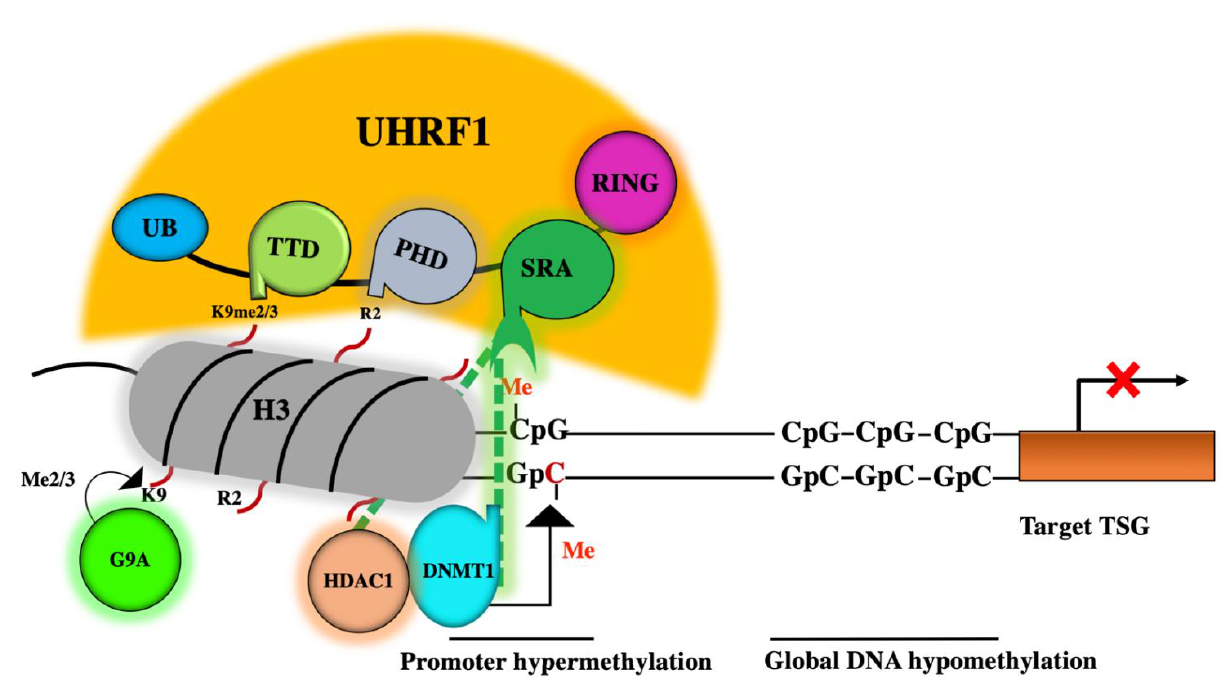
Figure 1. Role of the epigenetic reader UHRF1 (ubiquitin-like containing plant homeodomain (PHD) and interesting new gene (RING) finger domains 1) in epigenetic silencing of tumor suppressor genes (TSGs). During DNA replication, the SET and RING-associated (SRA) domain of UHRF1 can read methylated CpG sites (hemimethylated DNA) located with TSG promoter. Via the SRA domain, UHRF1 also recruits DNA methyltransferase 1 (DNMT1) and guides it to methylate the unmethylated cytosine of the newly synthetized DNA strand, leading to hypermethylation of the TSG promoter with a global hypomethylation. Through the plant homeodomain (PHD) domain, UHRF1 can bind to unmodified arginine 2 of histone 3 and via its tandem Tudor domain (TTD) domain, UHRF1 can recognize and bind to di or trimethylation of lysine 9 of histone 3 (H3K9me2 or H3K9me3). UHRF1 also uses its SRA domain to recruit histone deacetylase 1 (HDAC1) and recruits histone methyltransferase G9a, leading to histone 3 deacetylation and methylation, respectively. The consequence is the epigenetic silencing of TSGs.